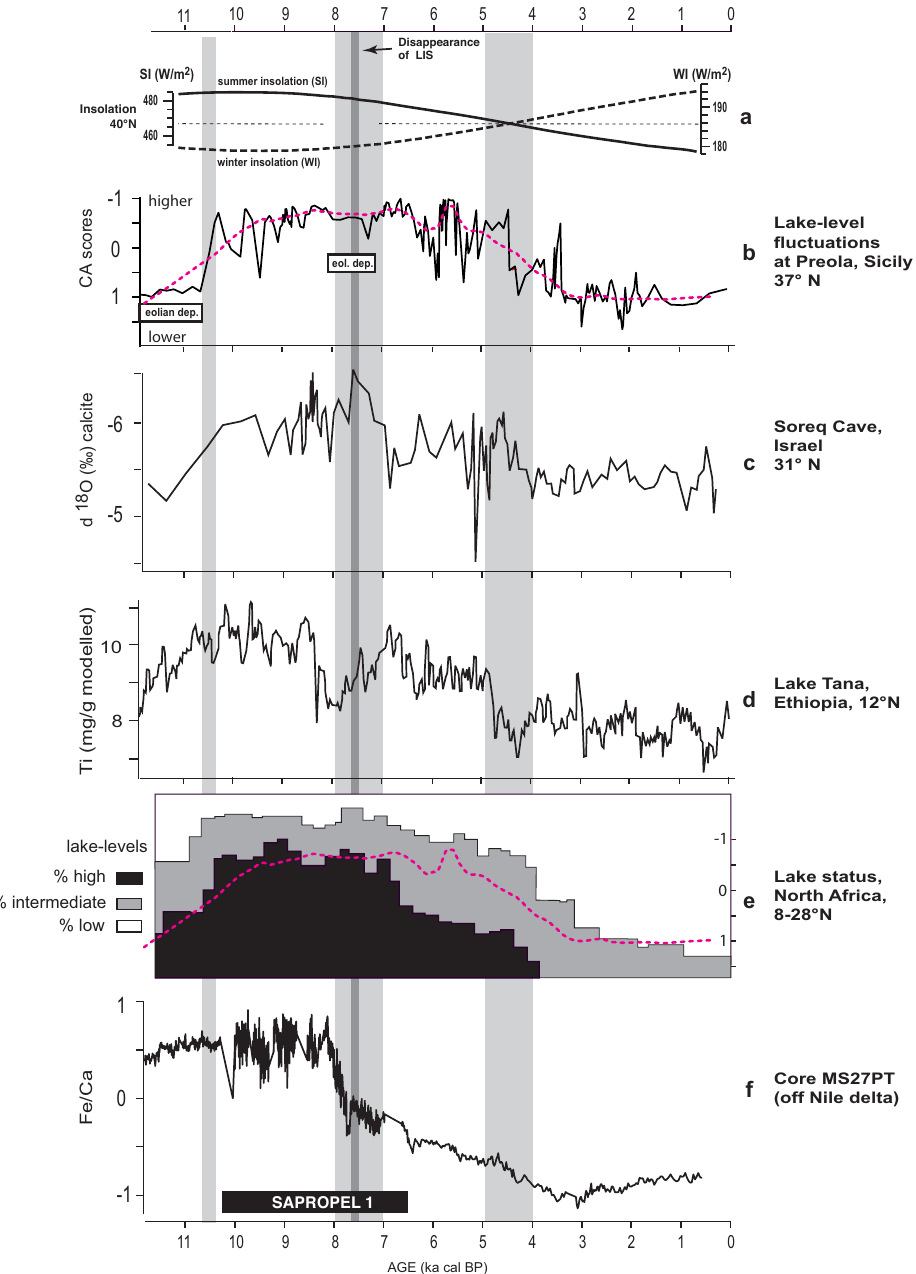
Figure 7 Fig. 7. Comparison between palaeoclimatic and palaeohydrological records from the Mediterranean area and North Africa, i.e. (a) curve of summer and winter insolation at 40 ◦ N (Berger and Loutre, 1991), (b) lake-level record from Lake Preola in south-central Mediterranean (Magny et al., 2011b; smoothed curve in red), (c) oxygen-isotope record from Soreq Cave (Bar-Matthews et al., 1998), (d) Ti record from Lake Tana in Ethiopia (Marshall et al., 2011), (e) lake-level status of North African lakes between 8 ◦ and 28 ◦ N (Hoelzmann et al., 1998; Gasse and Roberts, 2004), and (f) Fe/Ca record from core MS27PT off the Nile delta (Revel et al., 2010). The red dotted curve in (e) is the smoothed Preola lake-level record (see panel b ). Vertical grey bands indicate (i) the periods of disappearance of the Fennoscandian and Laurentide ice sheets according to Renssen et al. (2009), Jansson and Kleman (2004) and T¨ornqvist and Hijma (2012) with an episode of increasing sea-level rise around 7600calBP (Carlson et al., 2008), and (ii) periods of major climate change around 10500 and 5000–